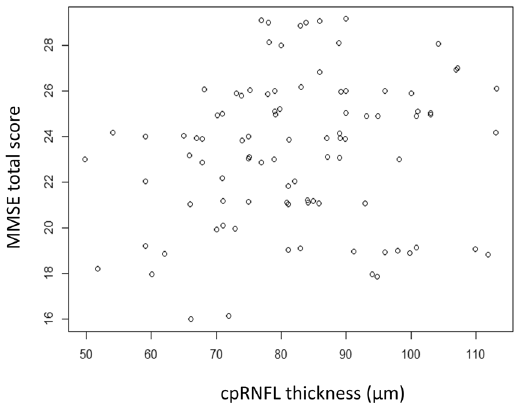
Figure 5. The relationship between the Mini Mental State Examination total score and the circumpapillary retinal nerve fiber layer thickness. No significant relationship was observed (p = 0.17, linear mixed